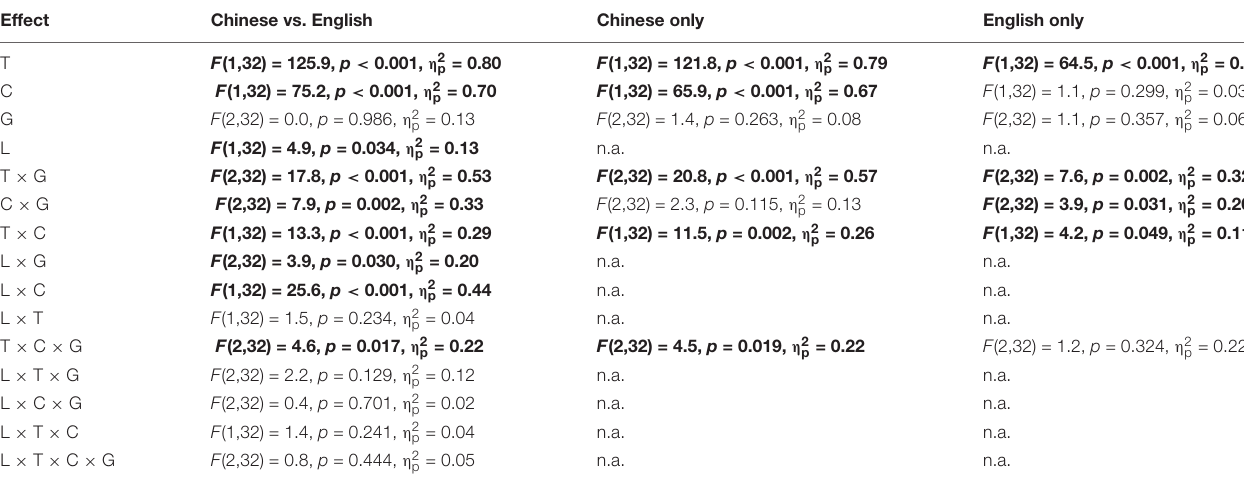
FIGURE 1 | Pre(green)–post(blue) training effects in consistent and inconsistent word reading in Chinese (A) and English (B) for the three groups (control group, metalinguistic training group, and working memory training group). Error bars represent standard deviations. ∗ Indicates significant training effects. TABLE 3 | Results of repeated measures ANOVAs on word reading for combined and separate language analyses. Effect Chinese vs. English Chinese only English